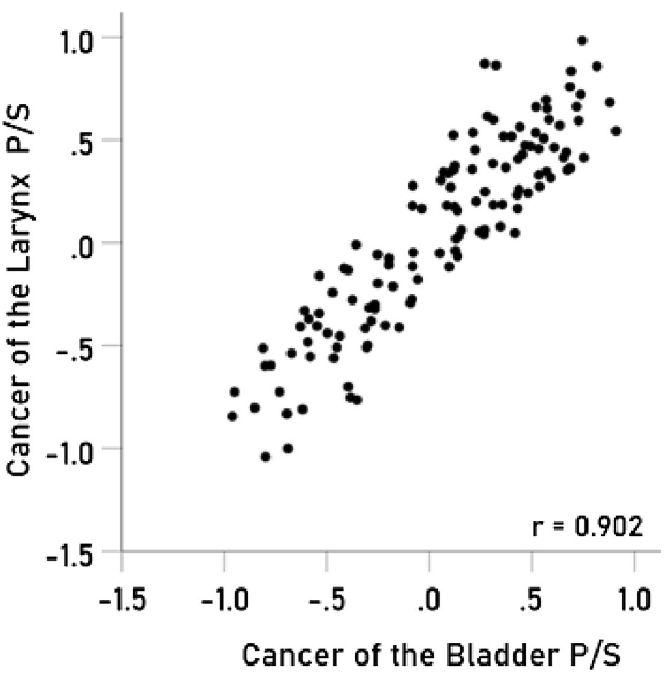
Figure 5. Immunogenetic P/S estimates for the cancer of larynx cancer are plotted against those for the cancer of bladder. P < 0.001; N =